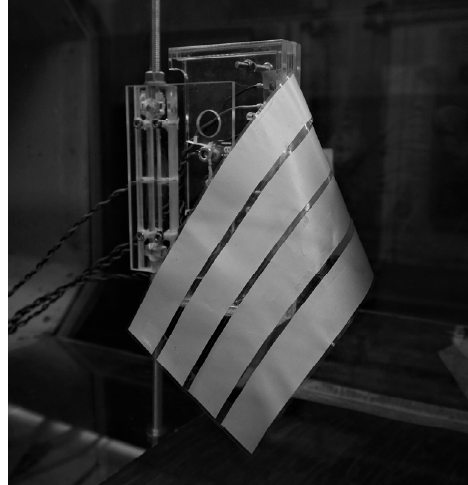
Figure 1. Structural configuration of the piezoelectric inverted flag (the wind flows left-to-right). Note the Perspex clamp, which is designed to provide a cantilever boundary condition at the flag root.